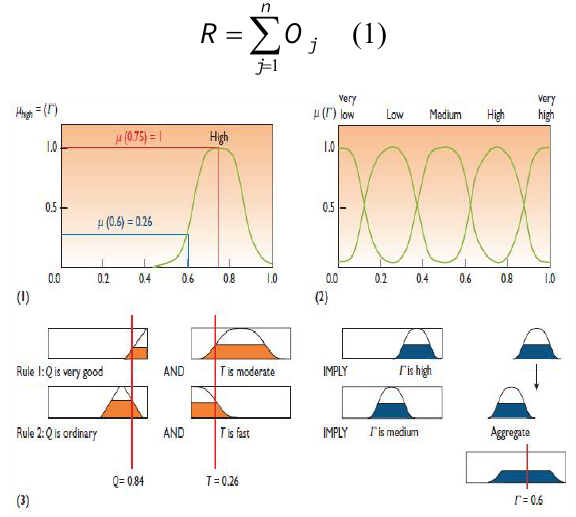
Fig. 1. Fuzzy logic inference and